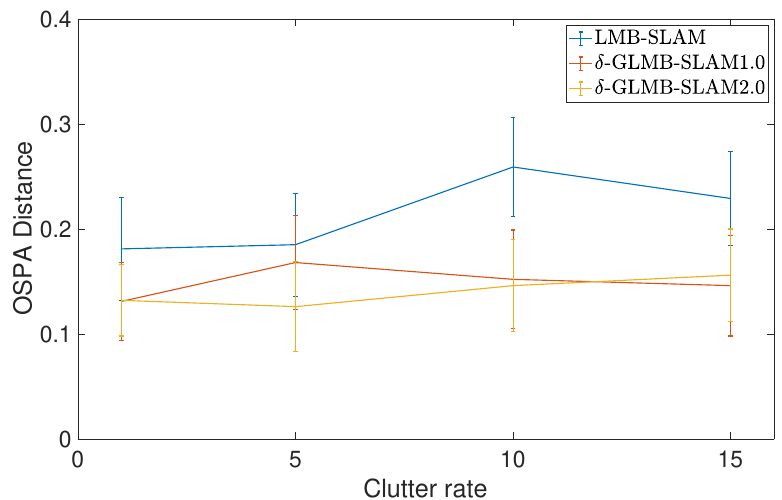
Figure 5. Comparison of the average Optimal Sub-Pattern Assignment (OSPA) distance with standard deviation under varying clutter rates. OSPA cut-off c = 0.5 and order p = 1.